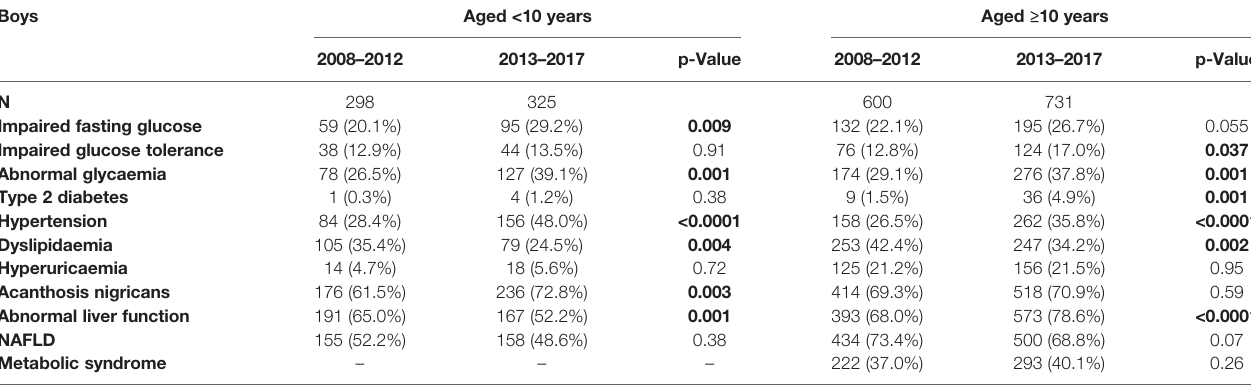
TABLE 4 | Incidence of cardiometabolic comorbidities among Chinese boys with obesity assessed between 2008 and 2017 in Hangzhou (Zhejiang Province,